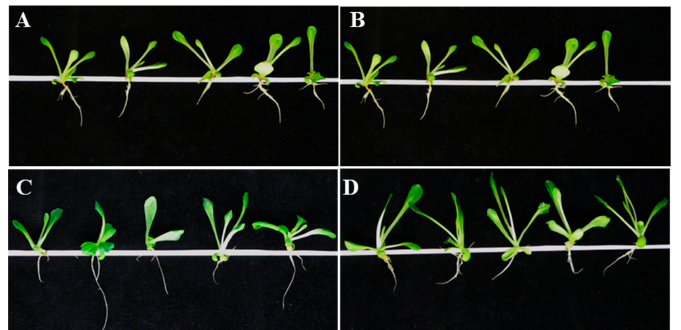
Figure 6. Representative images of Non-CNP pretreated and CNP-pretreated seedlings grown on MS media with 150 mM NaCl. ( A ) Non-CNP pretreated Breen; ( B ) CNP-pretreated Breen CNP; ( C ) Non-CNP pretreated Parris Island ( D ) CNP-pretreated Parris Island. Uniformly germinated seeds were chosen and grown on the MS media containing 150 mM NaCl for 21 days in the 16 h light/8 h dark.